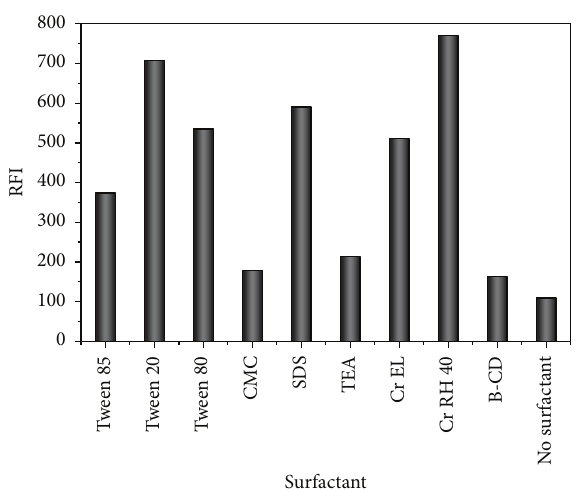
Figure 3: Effect of the type of organized media (0.5mL, 1% w/v solution of each) on fluorescence intensity of PTB (40ngmL −1 ).